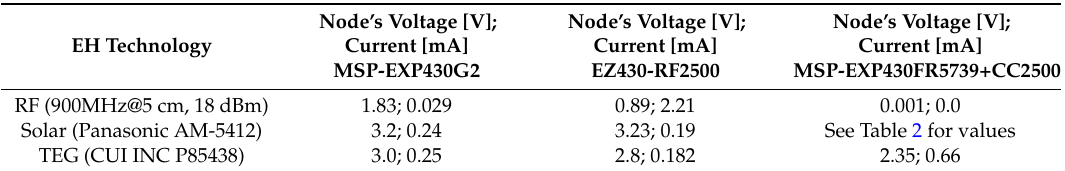
Table 1. Measured voltage and current values with different nodes powered by the RF, solar, and TEG energy harvesters.